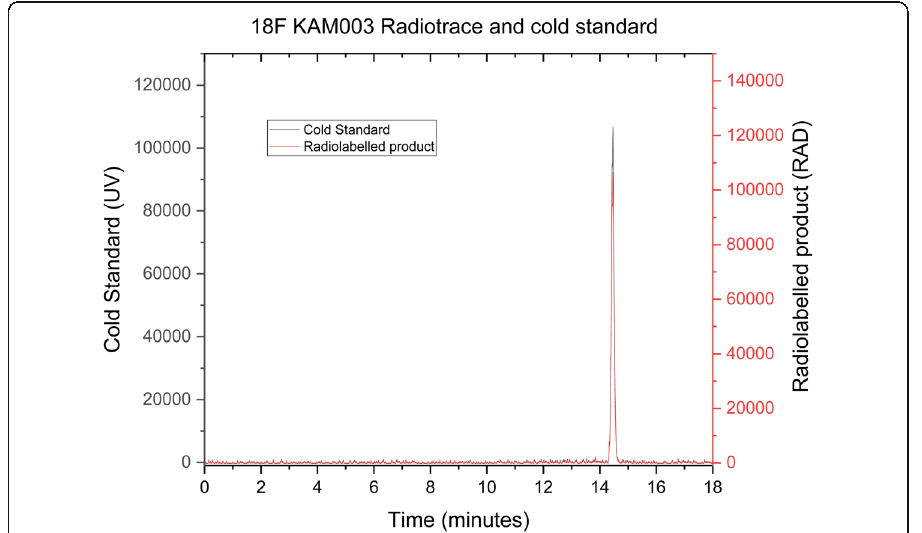
Fig. 6 18 F KAM003 identity confirmation using cold standard